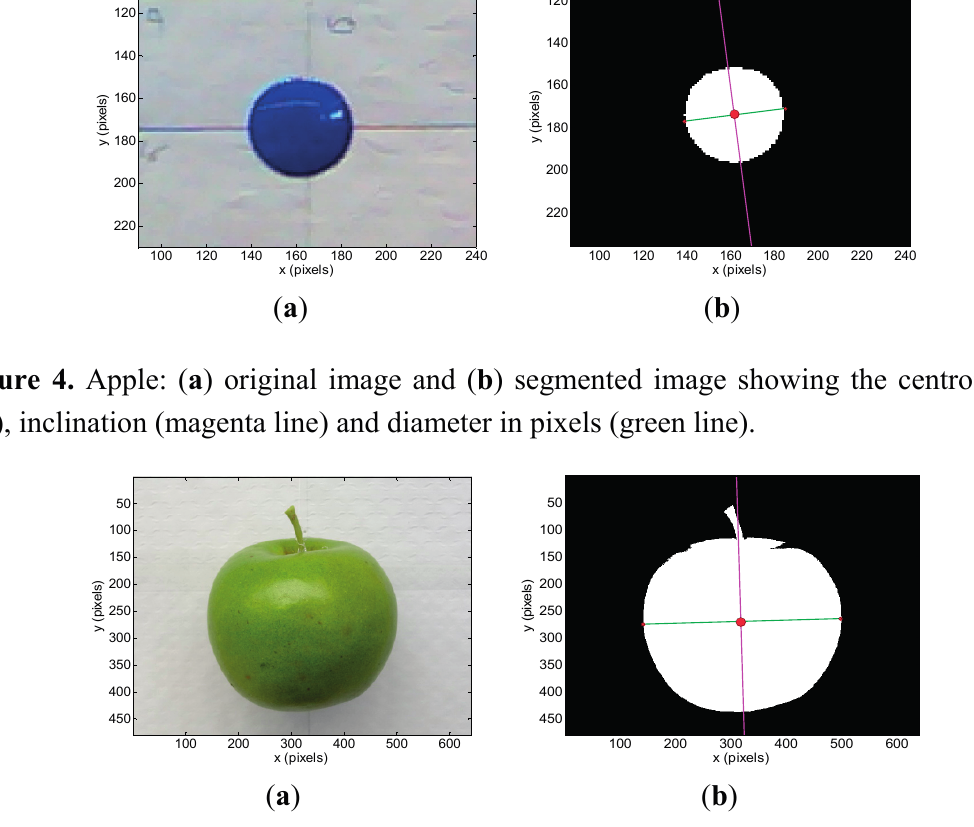
Figure 5. Pear: ( a ) original image and ( b ) segmented image showing the centroid (red dot), inclination (magenta line) and diameter in pixels (green